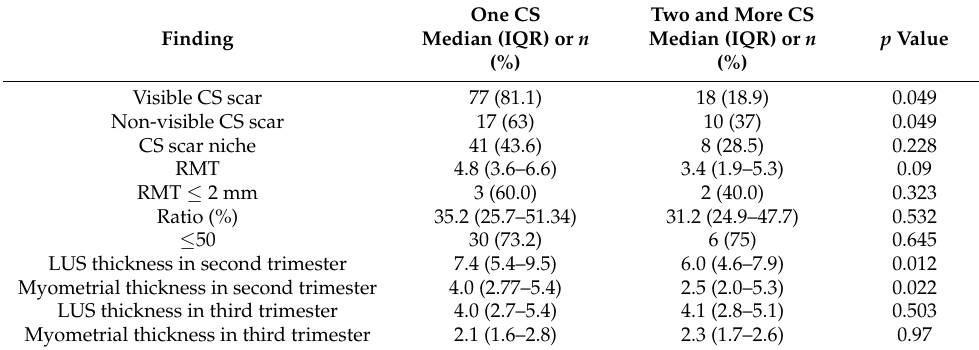
Table 5. Ultrasound findings in women after one ( n = 94) or two or more ( n = 28) previous CS.